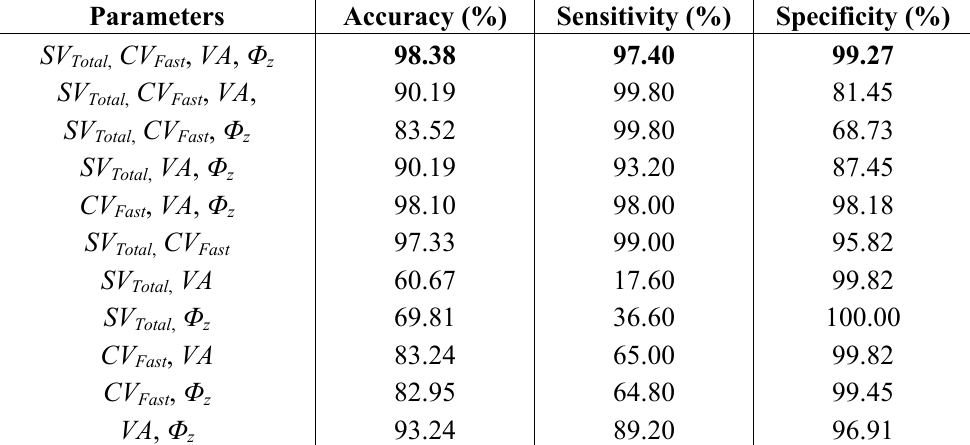
Table 4. The testing results with different parameter combinations.